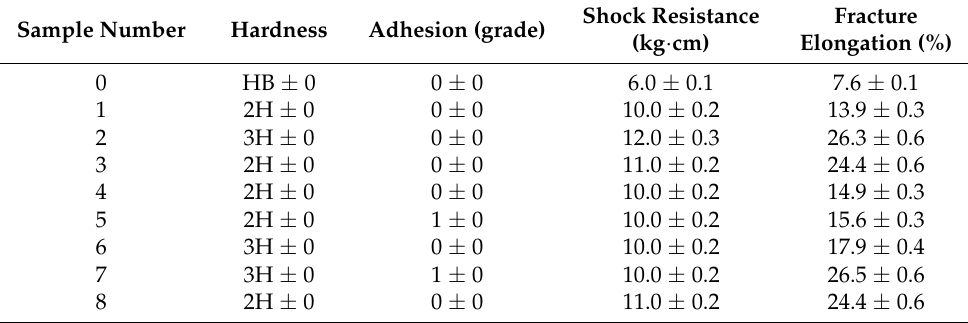
Table 5. Mechanical properties of coating films under different coating technologies.